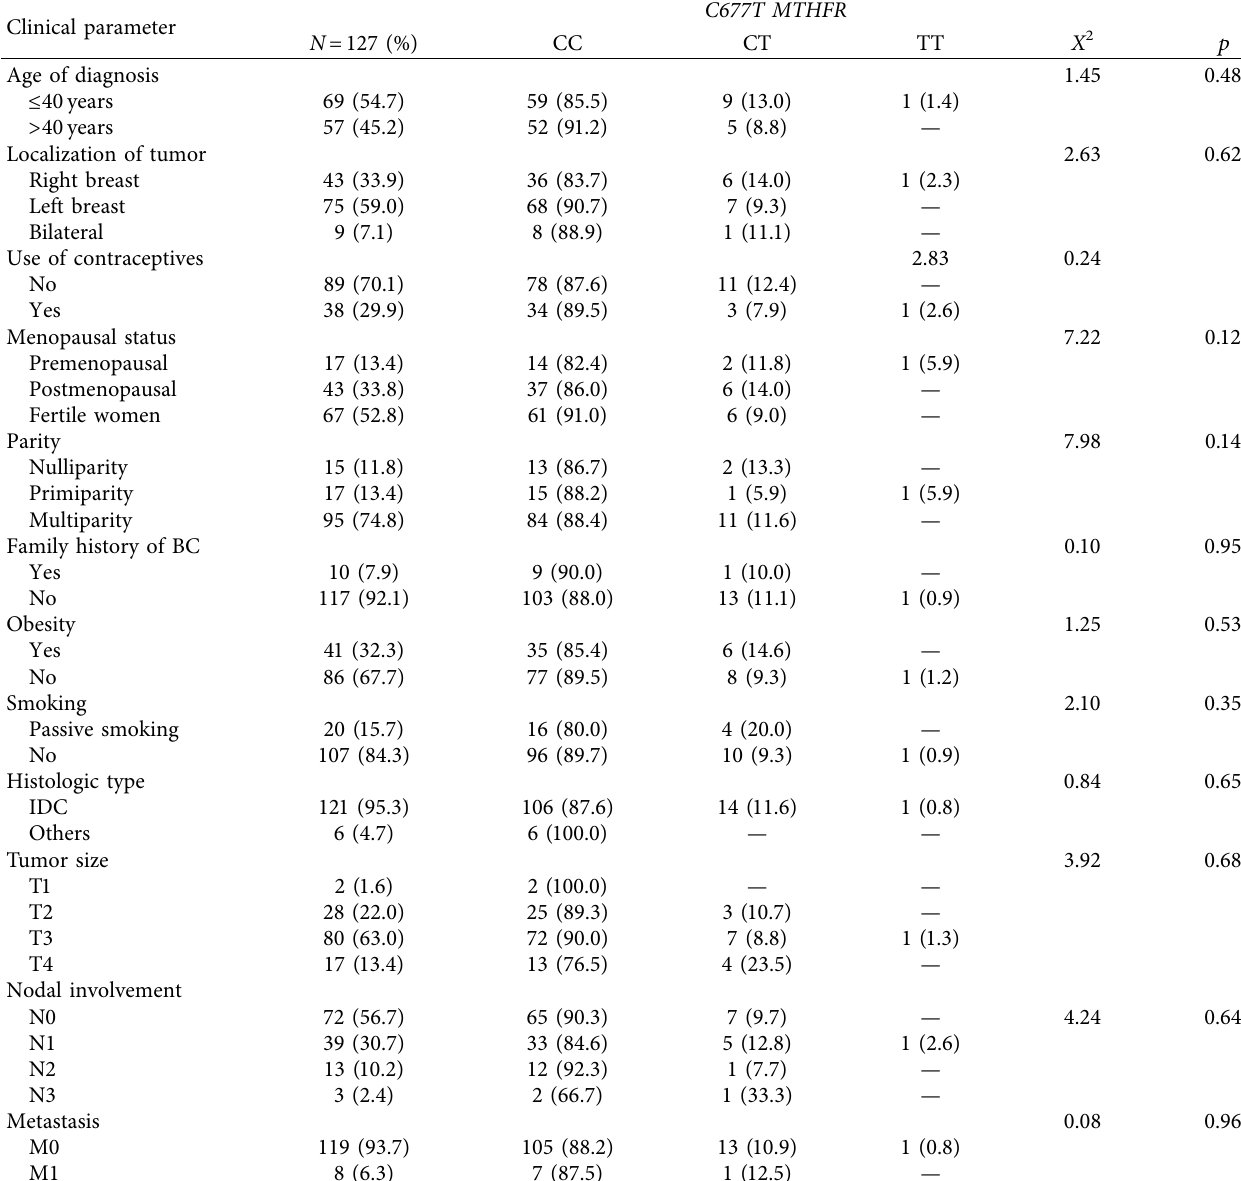
Table 1: Distribution of C677T MTHFR polymorphism by clinicopathological characteristics in the breast cancer group. Clinical parameter